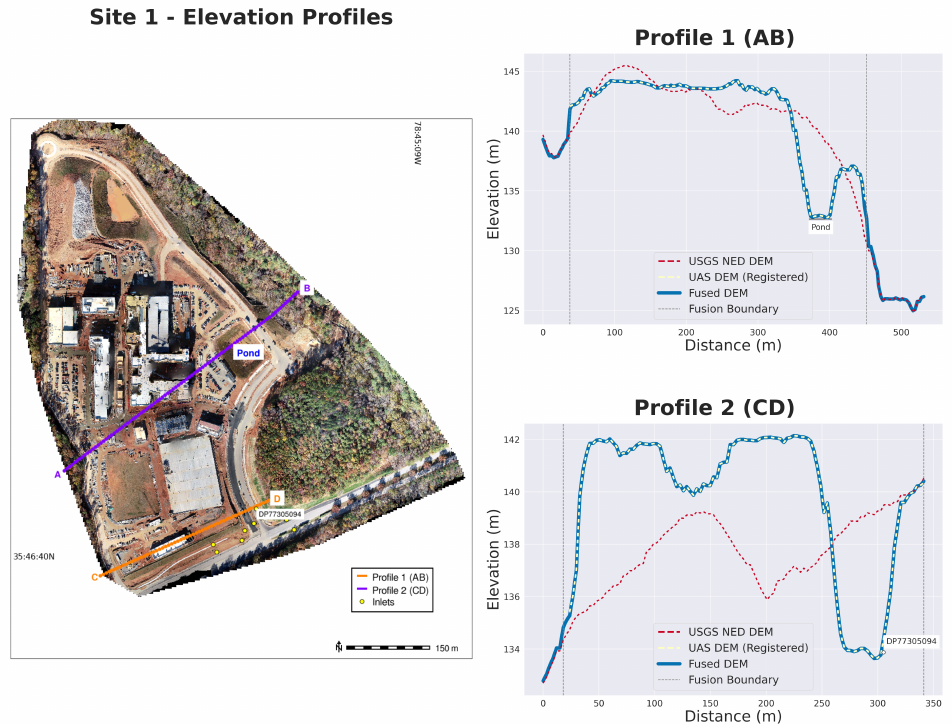
Figure 13. The elevation map with the location of profiles AB and CD, which illustrate the changes in elevation before and after the site grading (or construction) and the fusion of USGS NED DEM and UAS DEM along the site edges. Profile AB captures one of the sediment control ponds while Profile CD includes one of the surveyed